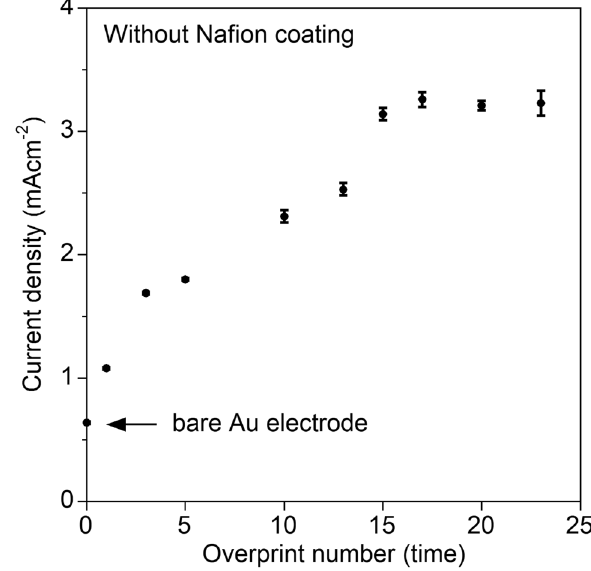
Fig. 4 Effect of the overprint number of CuO NPs ink on the CA responds with 0.1 mM of glucose concentrations at the potential of 0.5 V (vs. Ag/AgCl). The overprint number = 0 means bare Au elec- trode. These printed CuO NPs/Au electrodes were tested